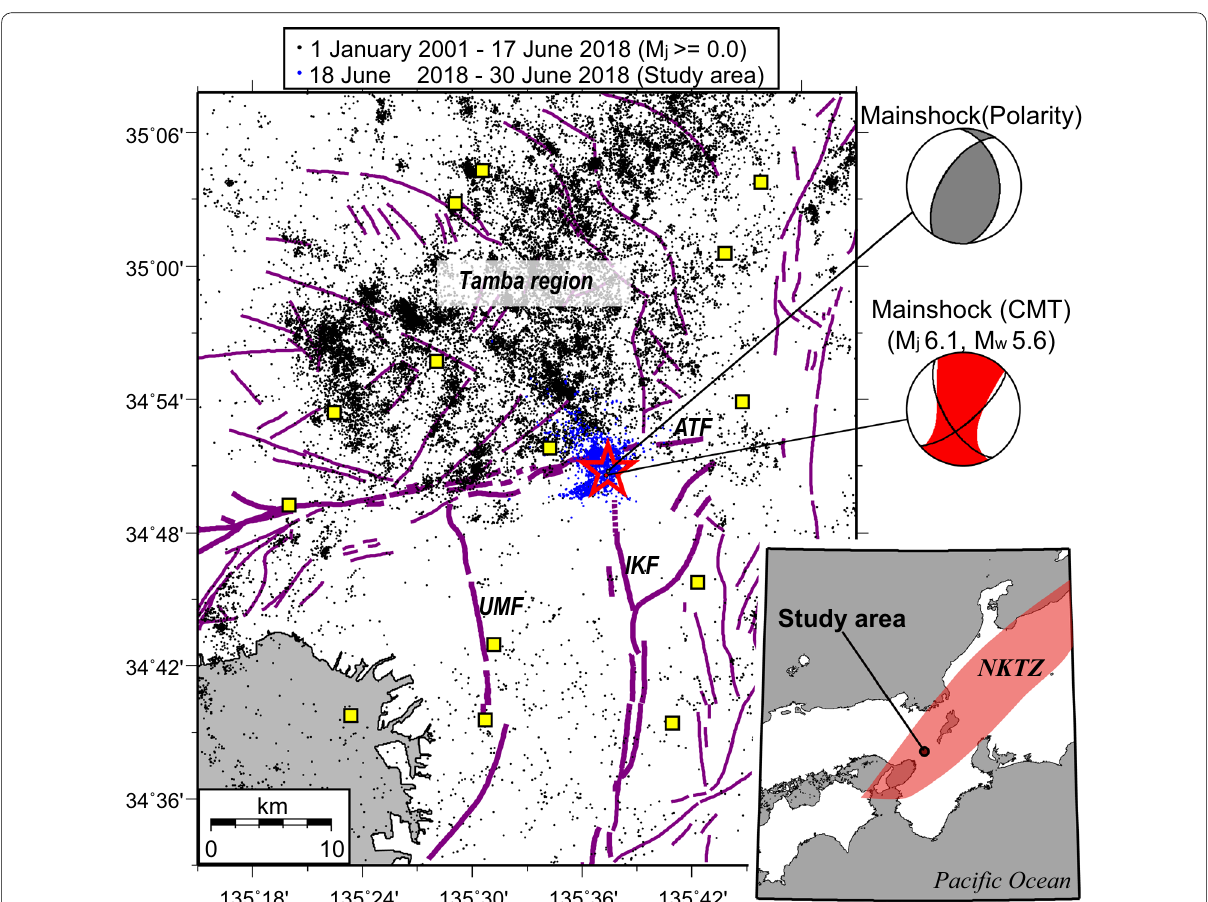
Fig. 1 Tectonic map of the study region and recent seismicity. The red star indicates the mainshock epicenter. The focal mechanism was constrained using the P-wave first-motion data (gray beach ball) and CMT solution (red beach ball) estimated by JMA. The black and blue dots denote the epicenters determined by JMA before (from 1 January 2001 to 17 June 2018) and after (from 18 to 30 June 2018 in the study area) the mainshock rupture, respectively. The yellow squares denote the permanent seismic stations used in the analysis. The Arima-Takatsuki (ATF), Ikoma (IKF), and Uemachi (UMF) fault zones are shown as thick purple lines, and the other major active faults are shown as thin purple lines. The inset shows a regional map of the studied area. NKTZ (red shading) denotes the Niigata–Kobe Tectonic Zone, as identified by the GNSS network